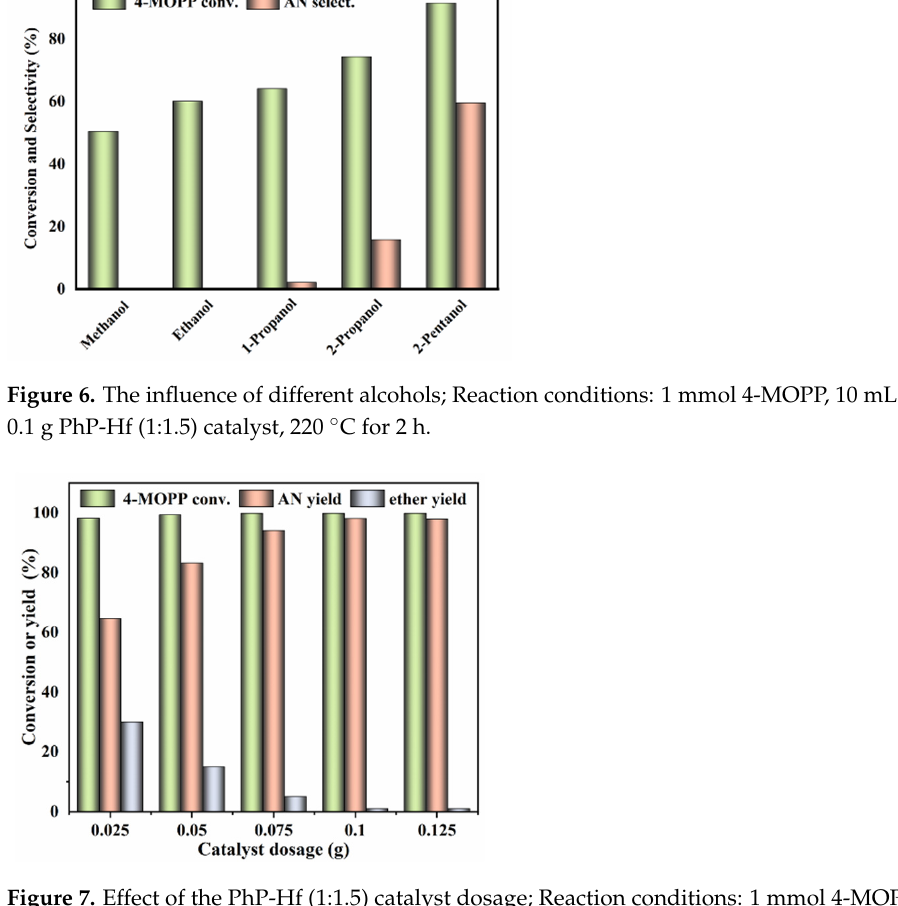
Figure 7. Effect of the PhP-Hf (1:1.5) catalyst dosage; Reaction conditions: 1 mmol 4-MOPP, 10 mL 2-pentanol, 220 °C for 2 h.